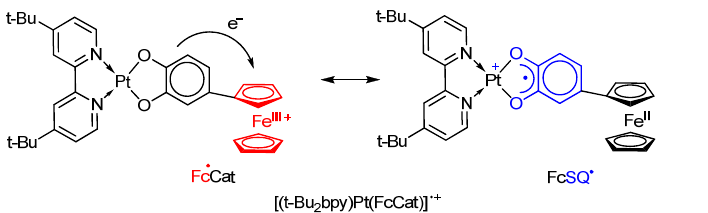
Scheme 31. Electron delocalization between catecholate and Fc group in platinum(II)